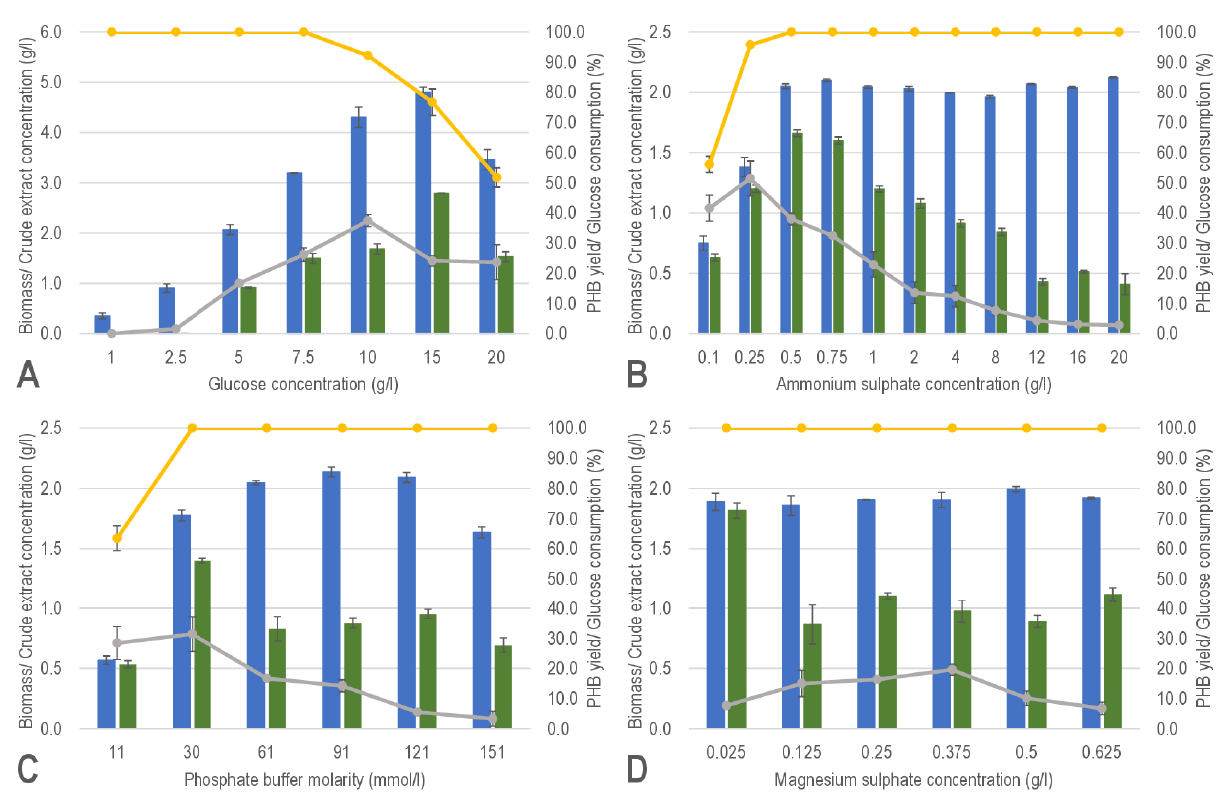
Figure 1. The influence of a selected component of the minimal propagation medium (( A ) — glucose concentration (g/L); ( B ) — ammonium sulfate concentration (g/L); ( C ) — phosphate buffer molarity (mmol/L) and ( D ) — magnesium sulfate concentration (g/L) on the monitored variables; •— biomass concentration (g/L); •— crude PHB-containing extract concentration (g/L); •— PHB yield (%); • — glucose consumption (%)).